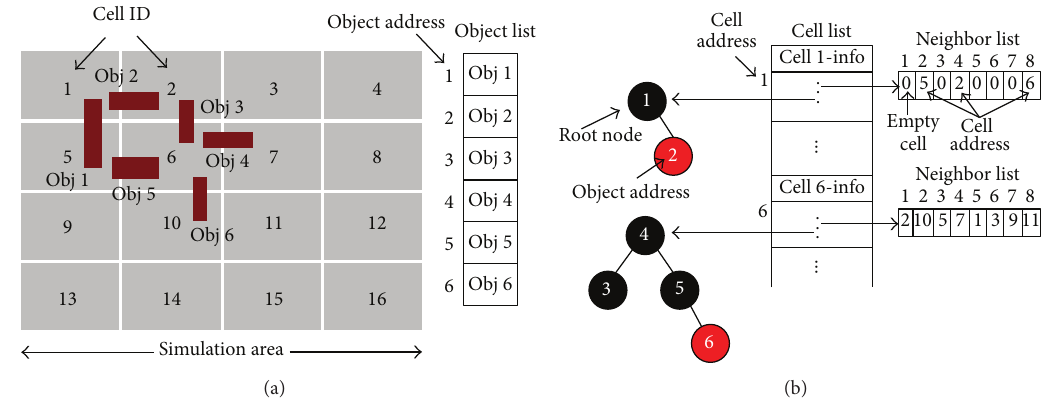
Figure 4: (a) Illustration of the object existence of the different cells. (b) Construction of the Red-Black tree for the different cells.